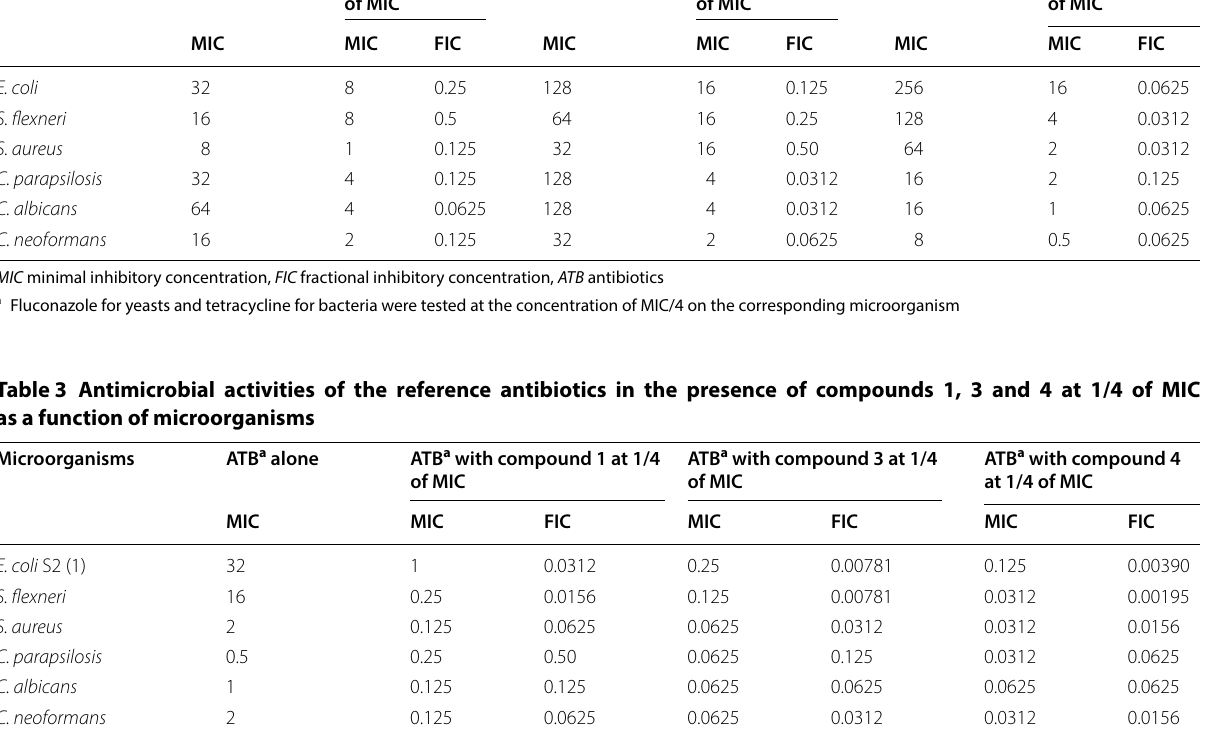
Table 2 Antimicrobial activities of the isolated compounds in the presence of reference antibiotics a at 1/4 of MIC as a function of microorganisms